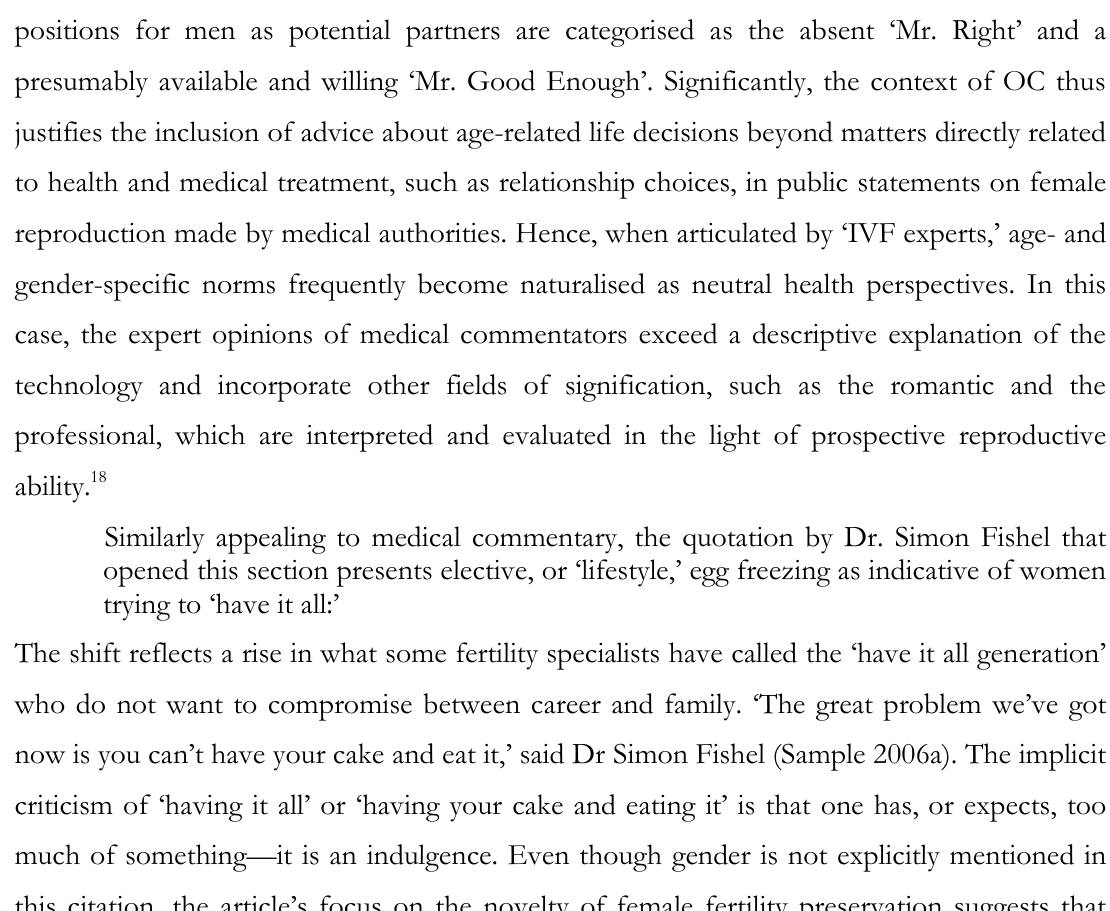
Lucy van de Wiel, For Whom The Clock Ticks: Reproductive Ageing and Egg Freezing in Dutch and British News Media Studies in the Maternal , 6(1), 2014,